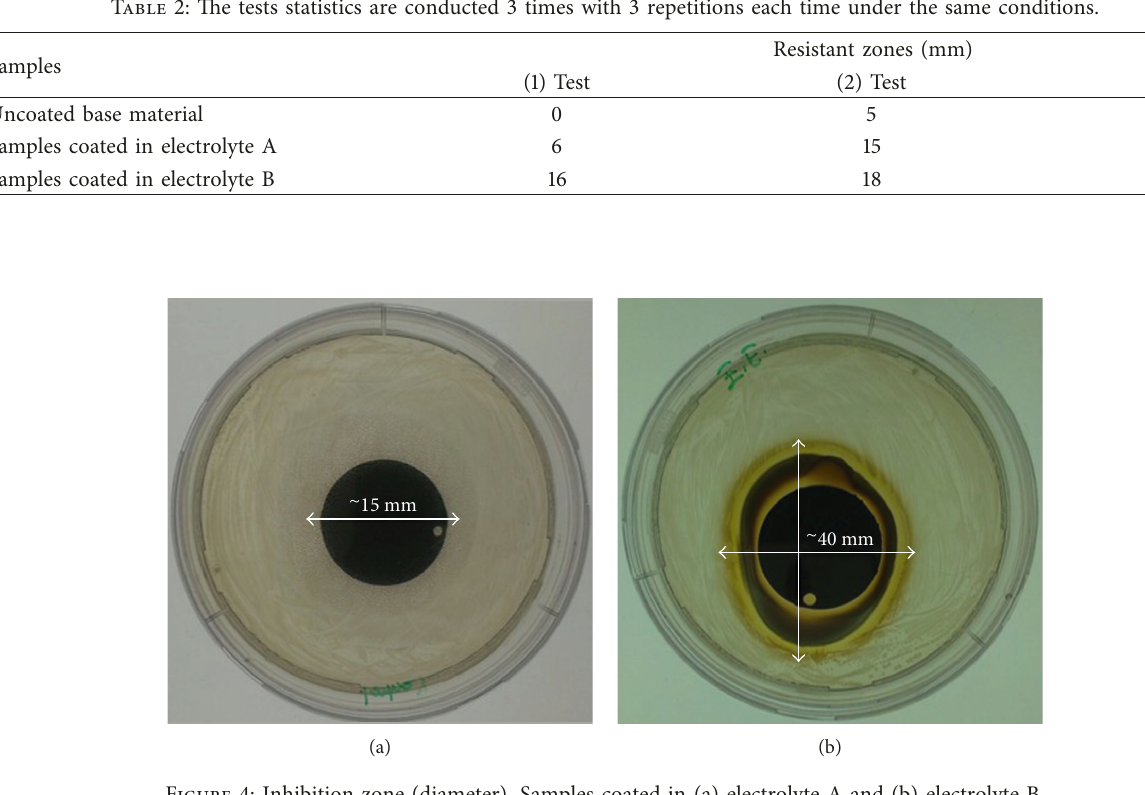
Figure 4: Inhibition zone (diameter). Samples coated in (a) electrolyte A and (b) electrolyte